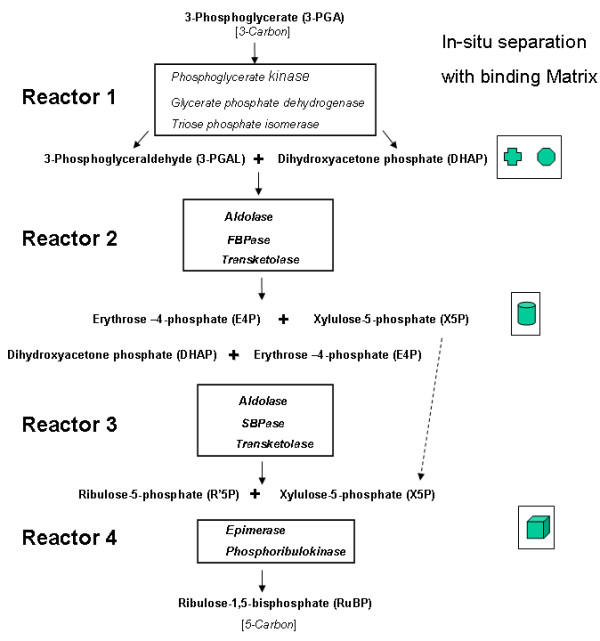
Arrangement of enzymes in four reactors with indicated enzyme complexes enabling internal channeling, greatly reduces volume and weight for regenerating reactors with faster overall conversion rate to RuBP starting with 3PGA making the system compatible for application in mobile devices in addition to stationary emitters [2]. The reactors may use the sugar binding entities at indicated positions, the solid symbols represent metabolite-bound matrix (binding protein entities), the plus, circle, cylinder and box are symbols for 3PGA, DHAP, X5P and RuBP binders respectively.